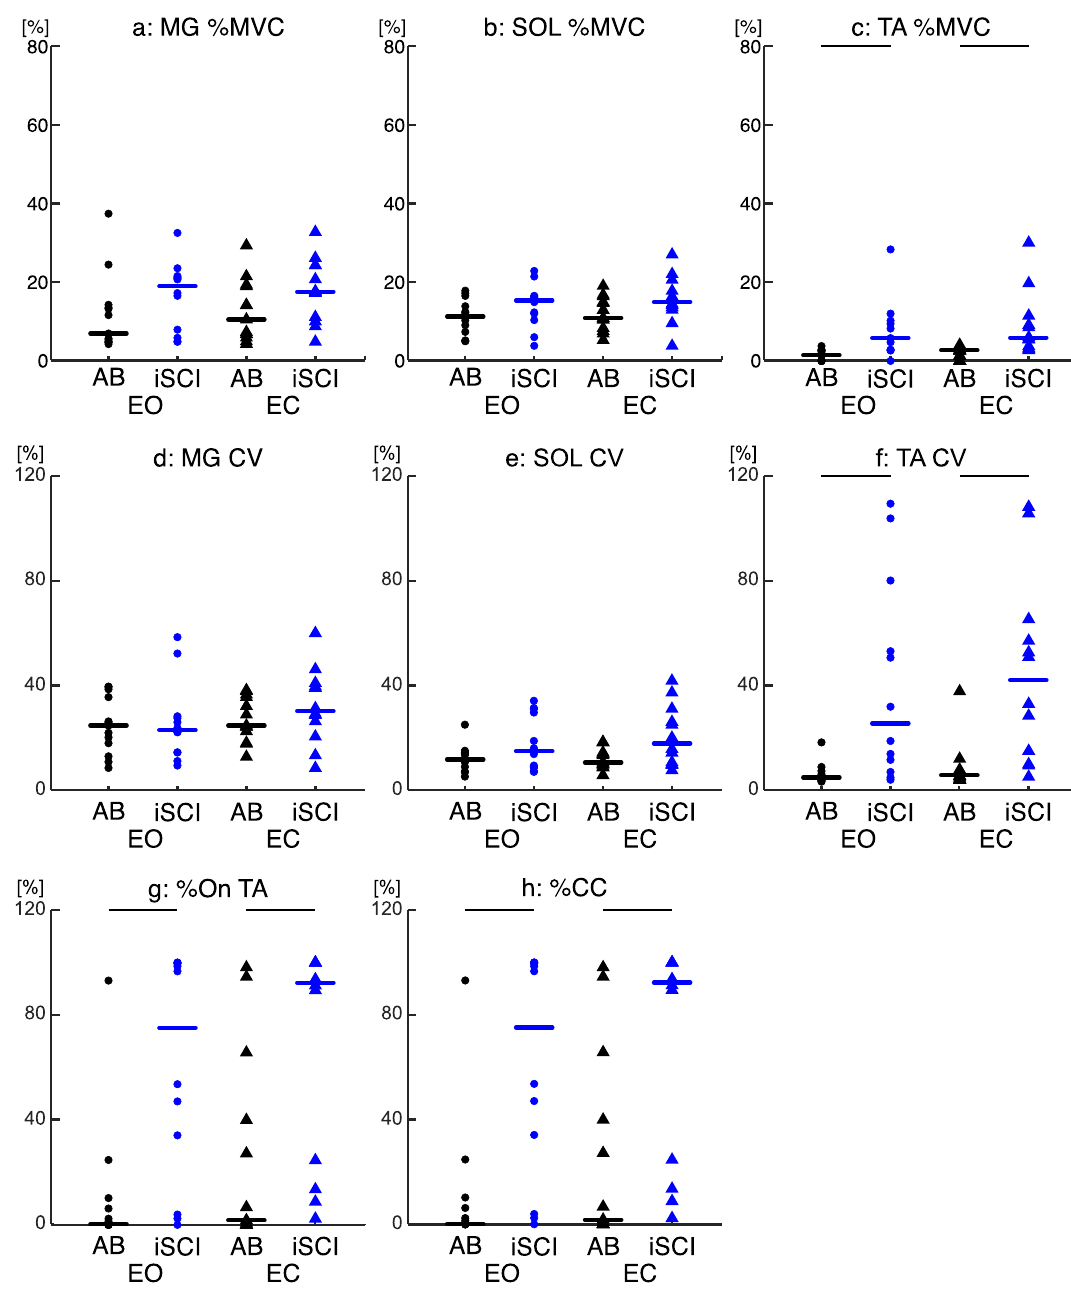
Figure 4. Comparison of measures of EMG (%MVC, CV, %On and %CC) between the AB- and iSCI-group. ( a ) Distribution of the mean MG EMG activity as a percentage of the MVC. ( b ) Distribution of the mean SOL EMG activity as a percentage of the MVC. ( c ) Distribution of the mean TA EMG activity as a percentage of the MVC. ( d ) Distribution of the mean MG CV. ( e ) Distribution of the mean SOL CV. ( f ) Distribution of the mean TA CV. ( g ) Distribution of the mean amount of time TA was active as a percentage. ( h ) Distribution of the mean amount of time the SOL and TA were active as a percentage. Group data presented for the AB- (black) and the iSCI-group (blue) in both EO and EC conditions. Individual participant data are plotted as circles for the EO condition and triangles for the EC condition. N = 13 for AB-group, and N = 12 for iSCI-groups. Thick black, blue, and red horizontal lines represent the group median. Thin black horizontal bar indicates a p-value <